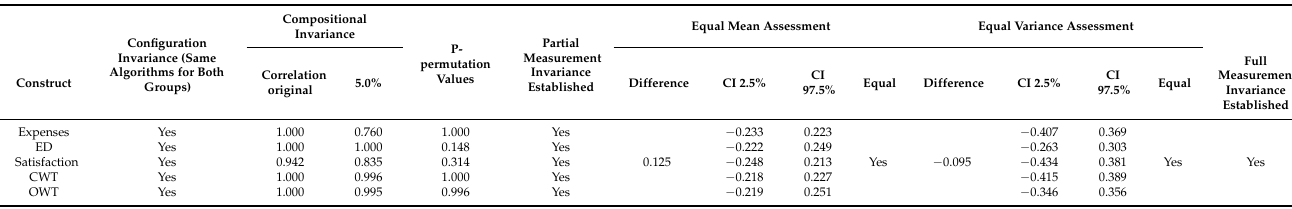
Table 7. Results of invariance